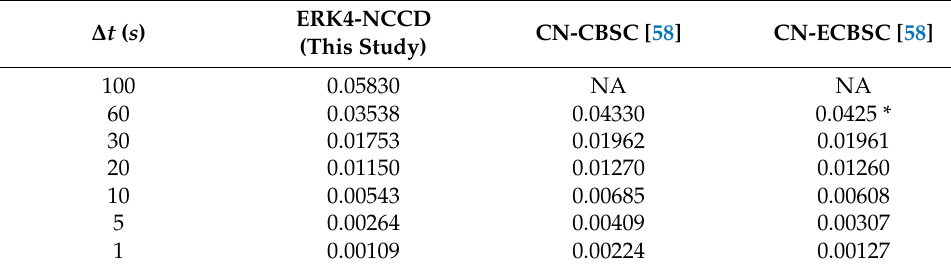
Table 1. Comparison of the L ∞ norm errors of several methods for different time steps ∆ t at t = 3000 s.